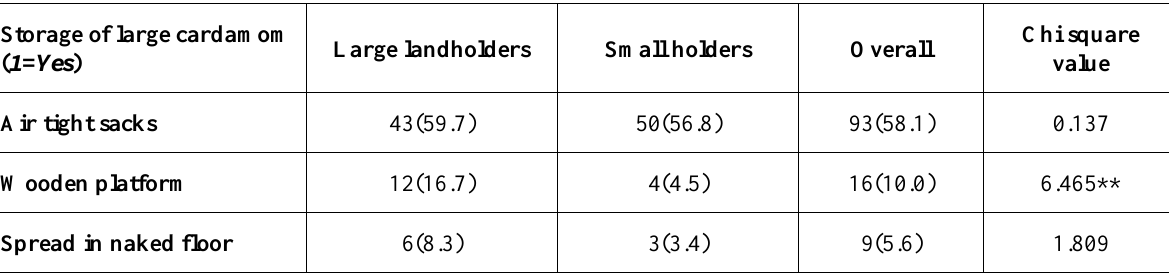
Table 8. Storage practice of the large cardamom by the farmers